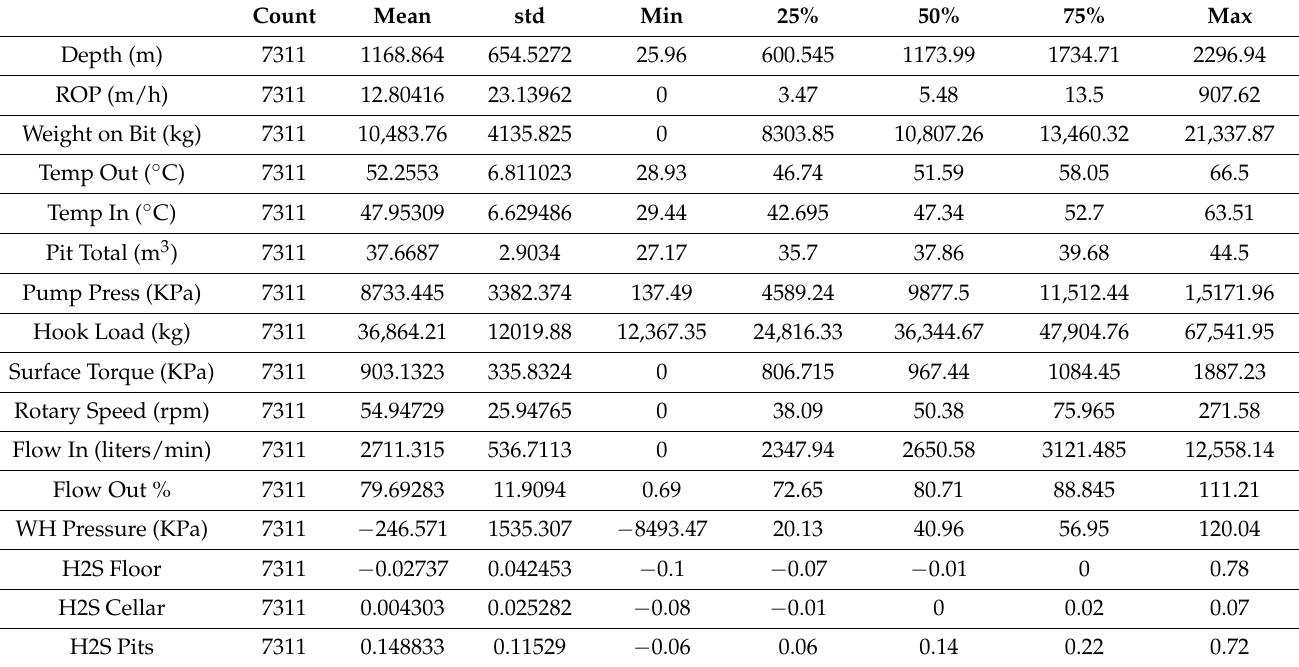
Table 1. Well 58–32 drilling dataset